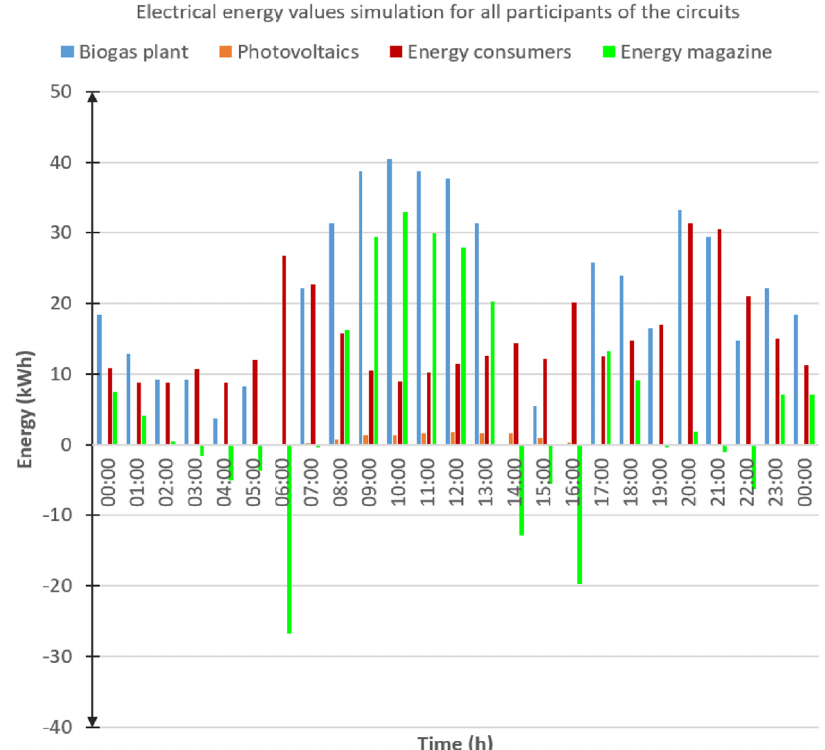
Figure 12. Electrical energy values simulation for all participants of the circuits on the virtual valve including the energy storage management. The energy storage grid management based on the distributed 10 kWh storage net-